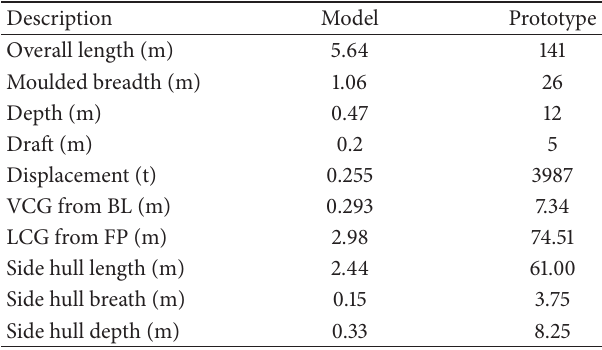
Table 2: Model dimensions.